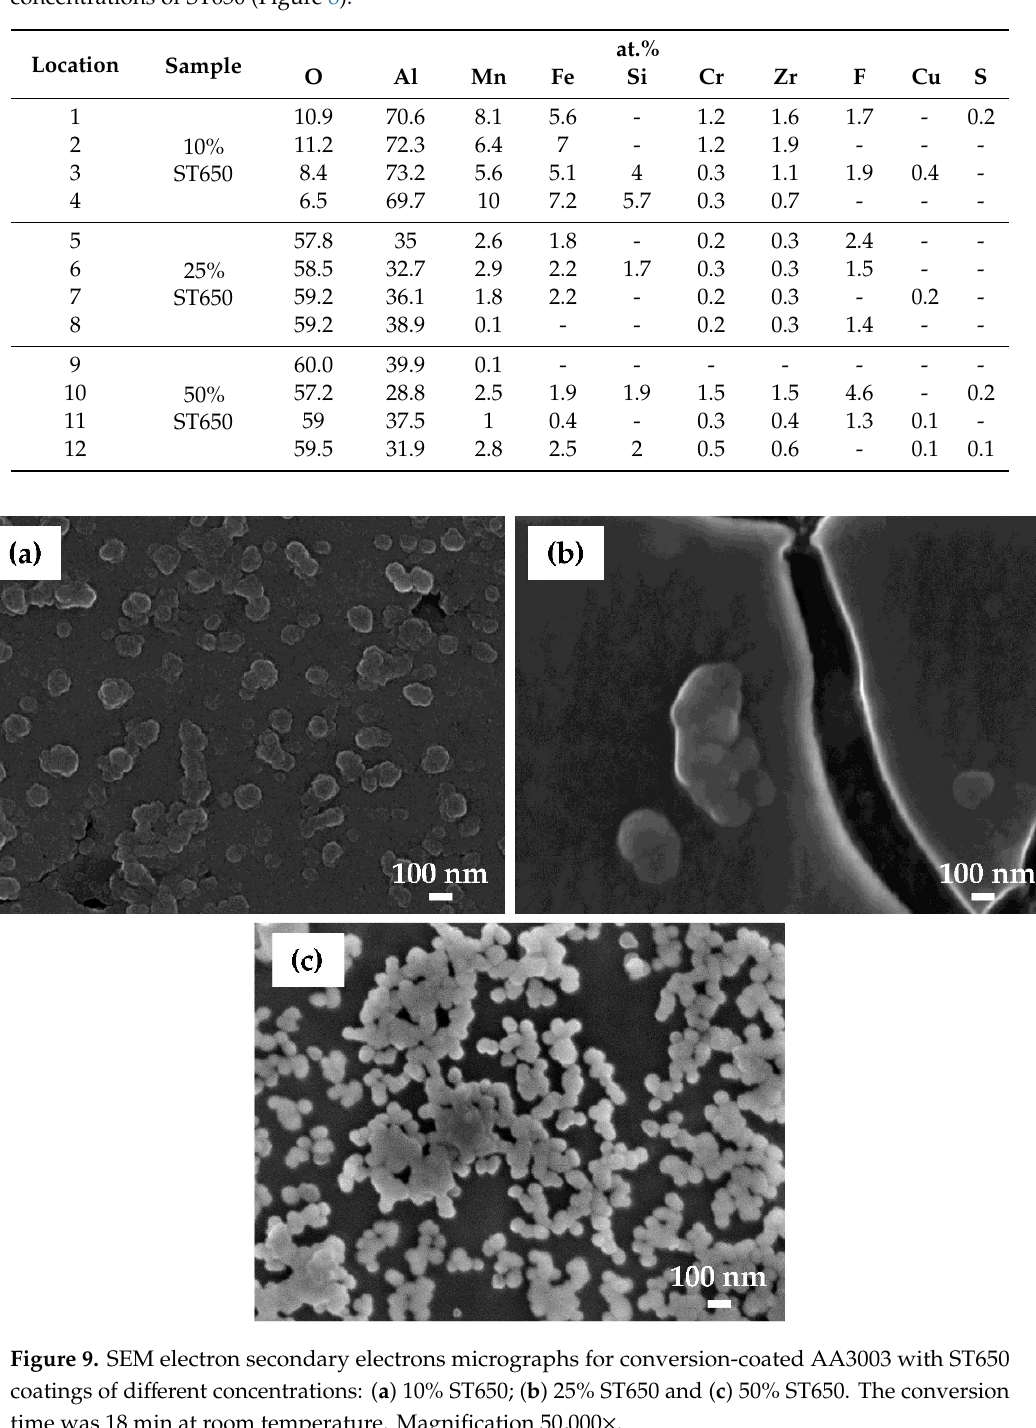
Table 4. The concentrations of elements obtained by EDS analysis of AA3003 coated with di ff erent concentrations of ST650 (Figure 8).